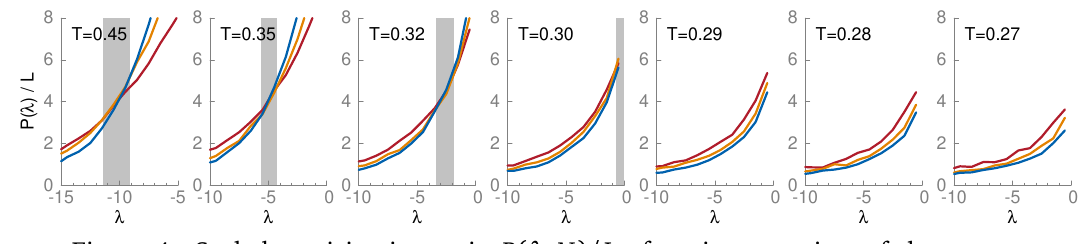
Figure 4: Scaled participation ratio P ( λ , N ) / L of stationary points of the ternary model from EF optimizations for all studied temperatures and system sizes N = 250,500,1000. As in Fig. 3, the corresponding mobility edge is indicated by a vertical